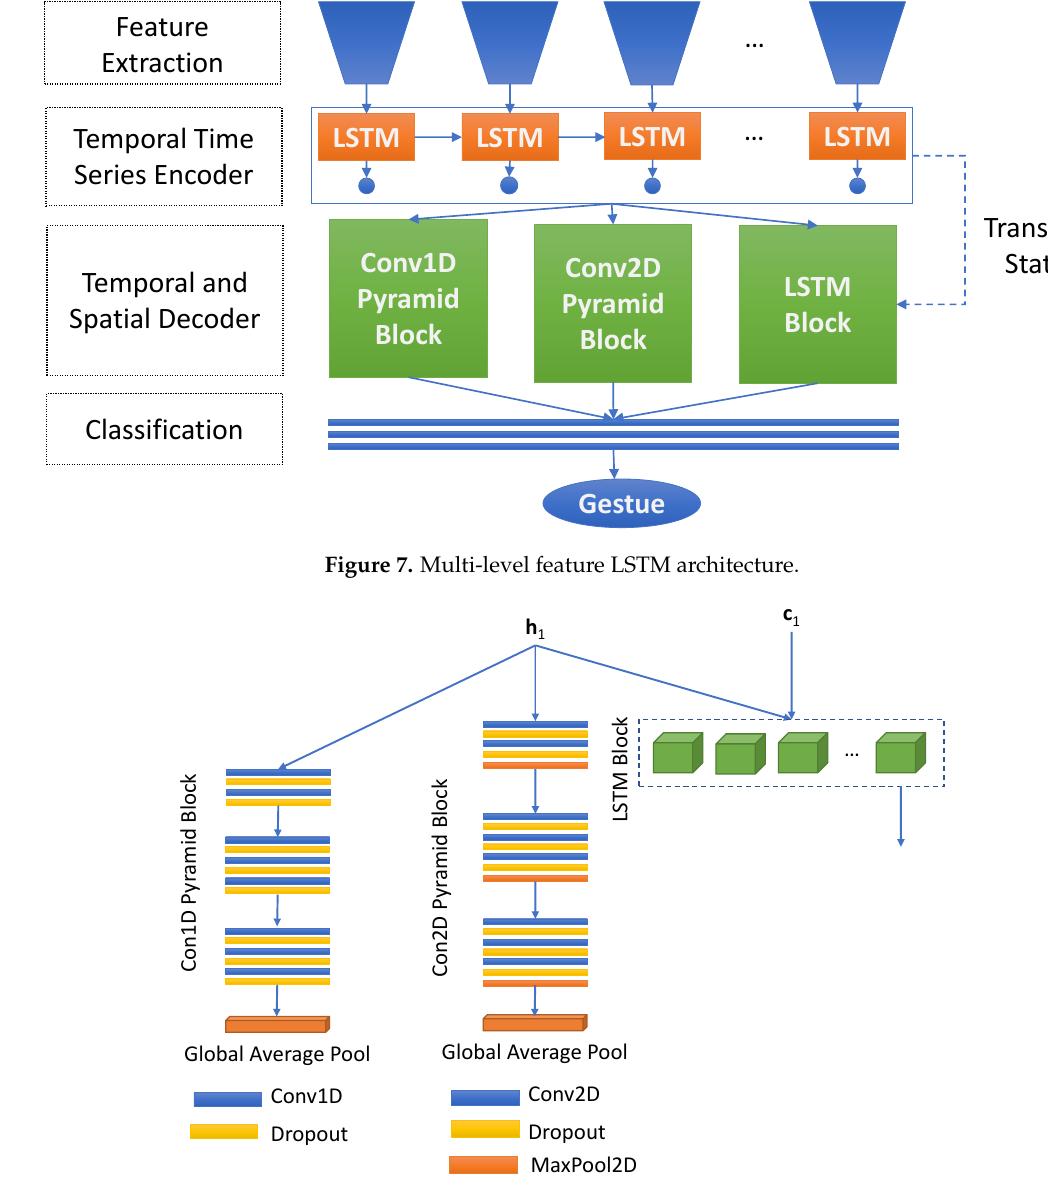
Figure 8. The structure of the LSTM block, Conv1D, and the Conv2D pyramid